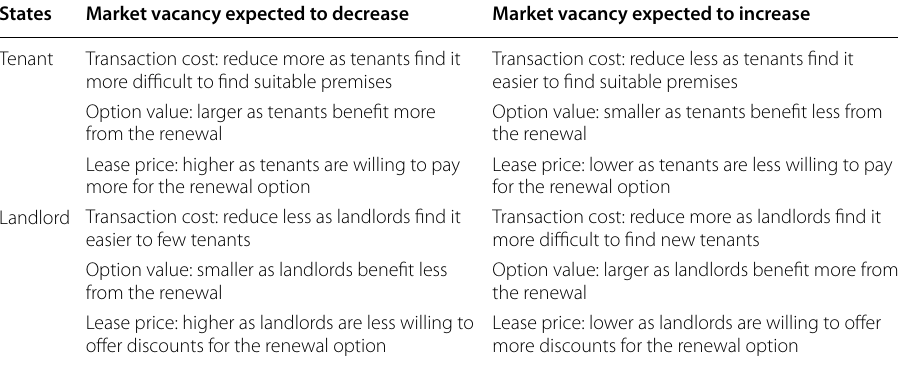
Table 1 Situations and value for counterparties States Market vacancy expected to decrease Market vacancy expected to